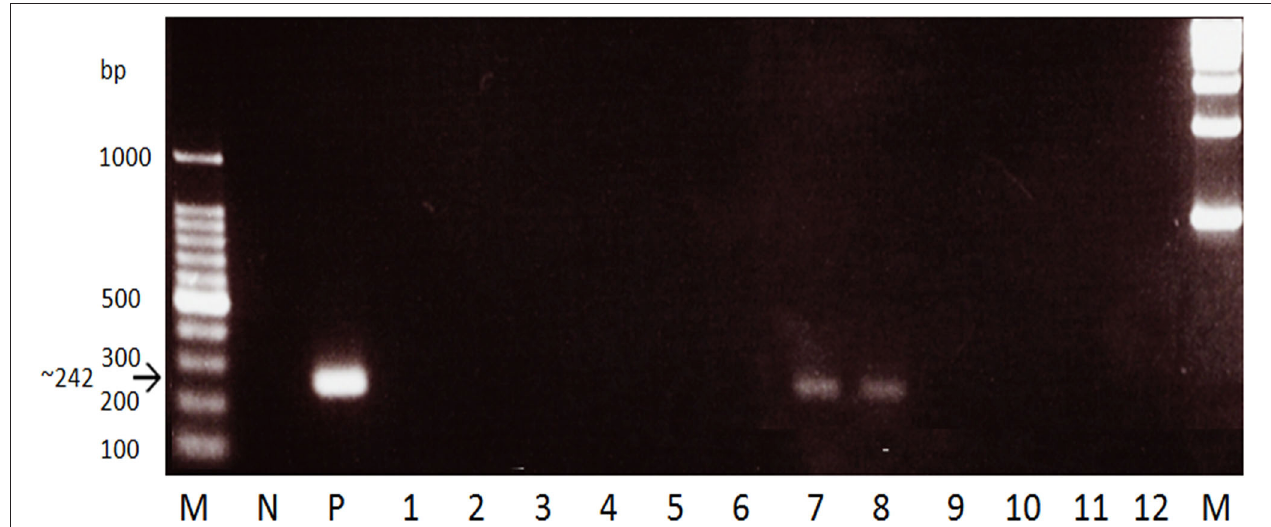
FIGURE 1 | Gel electrophoresis of the stool PCR for water buffaloes targeting the S. japonicum mitochondrial cox2-nad6 gene. M , marker. N , negative control (stool DNA from non-endemic cattle). P , positive control ( S. japonicum adult DNA template). Lanes 1-12, Water buffalo samples. A 242 bp band was seen in positive samples while none in